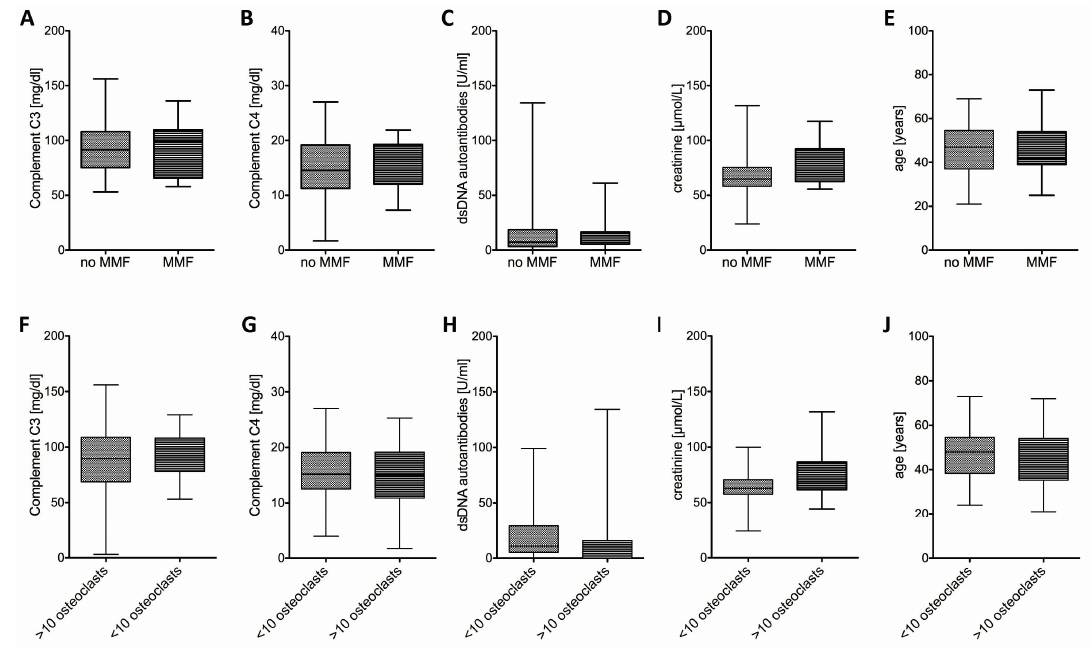
Figure 4. Disease activity was comparable for patients with or without MMF treatment. Disease activity status was similar in SLE patients who were under MMF medication as measured by ( A ) complement C3, ( B ) complement C4, and ( C ) dsDNA autoantibodies. Patients with low osteoclast counts had comparable ( F ) C3, ( G ) C4, and ( H ) dsDNA autoantibody titers. ( D , I ) Creatinine levels were also similar in both groups. Average age was similar in ( E ) MMF treated or untreated patients and in patients with ( J ) low or normal osteoclast count.